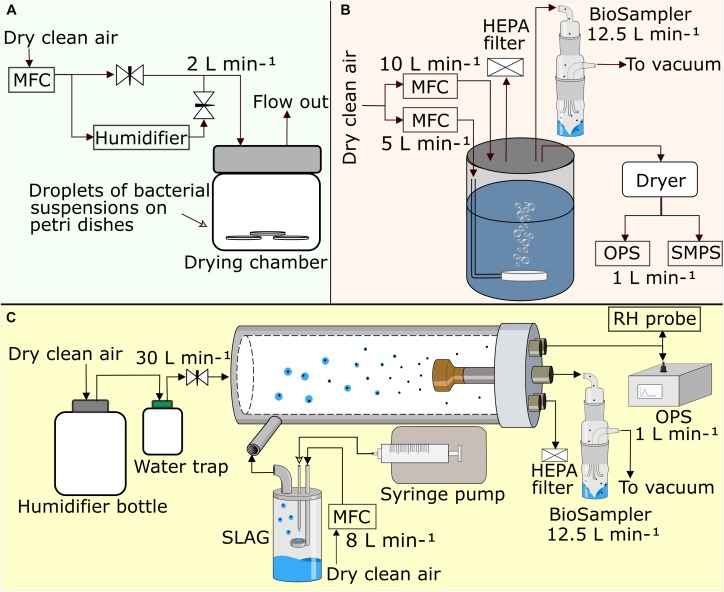
Schematic drawing of the three experimental setups for (A) surface drying in air with controlled RH, (B) aerosolization in bubble tank, and (C) aerosolization by SLAG into humidity conditioned flow tube. Black arrows show airflow directions. MFC, mass flow controller; OPS, optical particle sizer; SMPS, scanning mobility particle sizer; SLAG, sparging liquid aerosol generator; RH probe, relative humidity probe; HEPA filter, high efficiency particulate arresting filter.